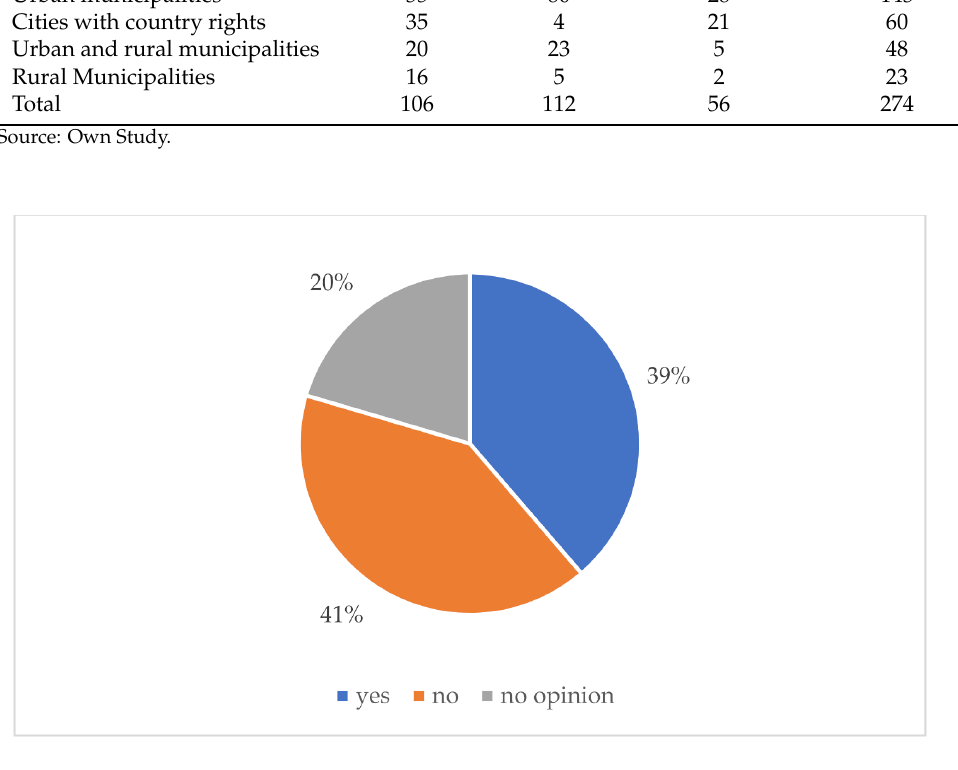
Figure 16. Concerns related to the implementation of EU climate and energy requirements in Poland. Respondents could select only one answer. Source: own